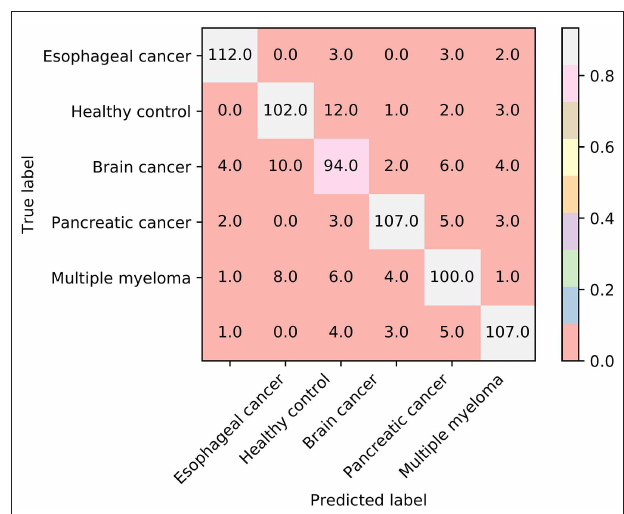
FIGURE 4 | The confusion map of seven classification rules on